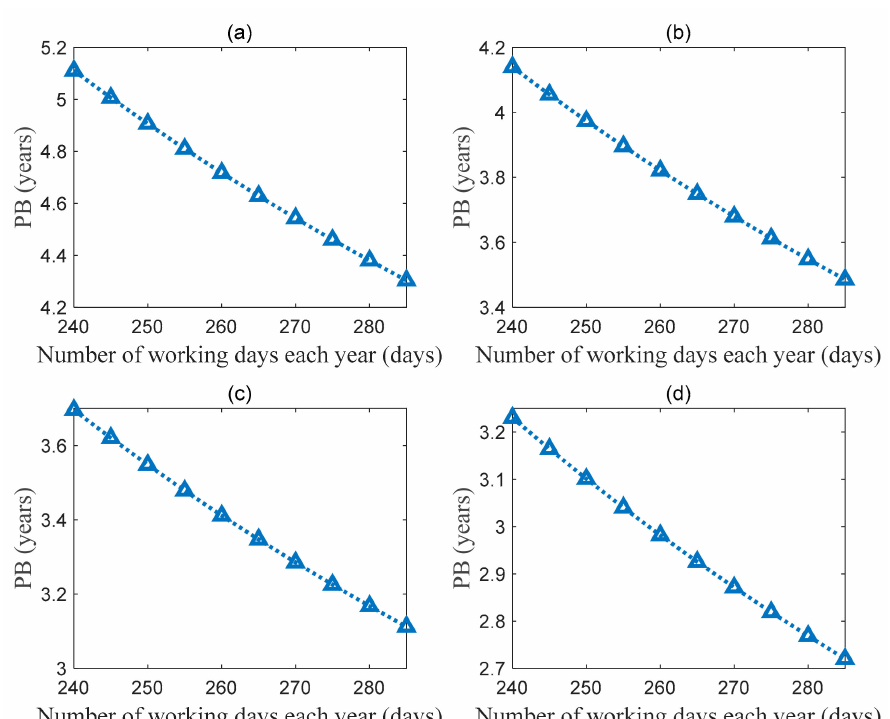
Figure 10. Evolution of the payback period (PB) vs. the number of working days each year when the daily travel distance is 500 km, fuel price is EUR 1.5/L, and the working fluid is ( a ) R245fa,